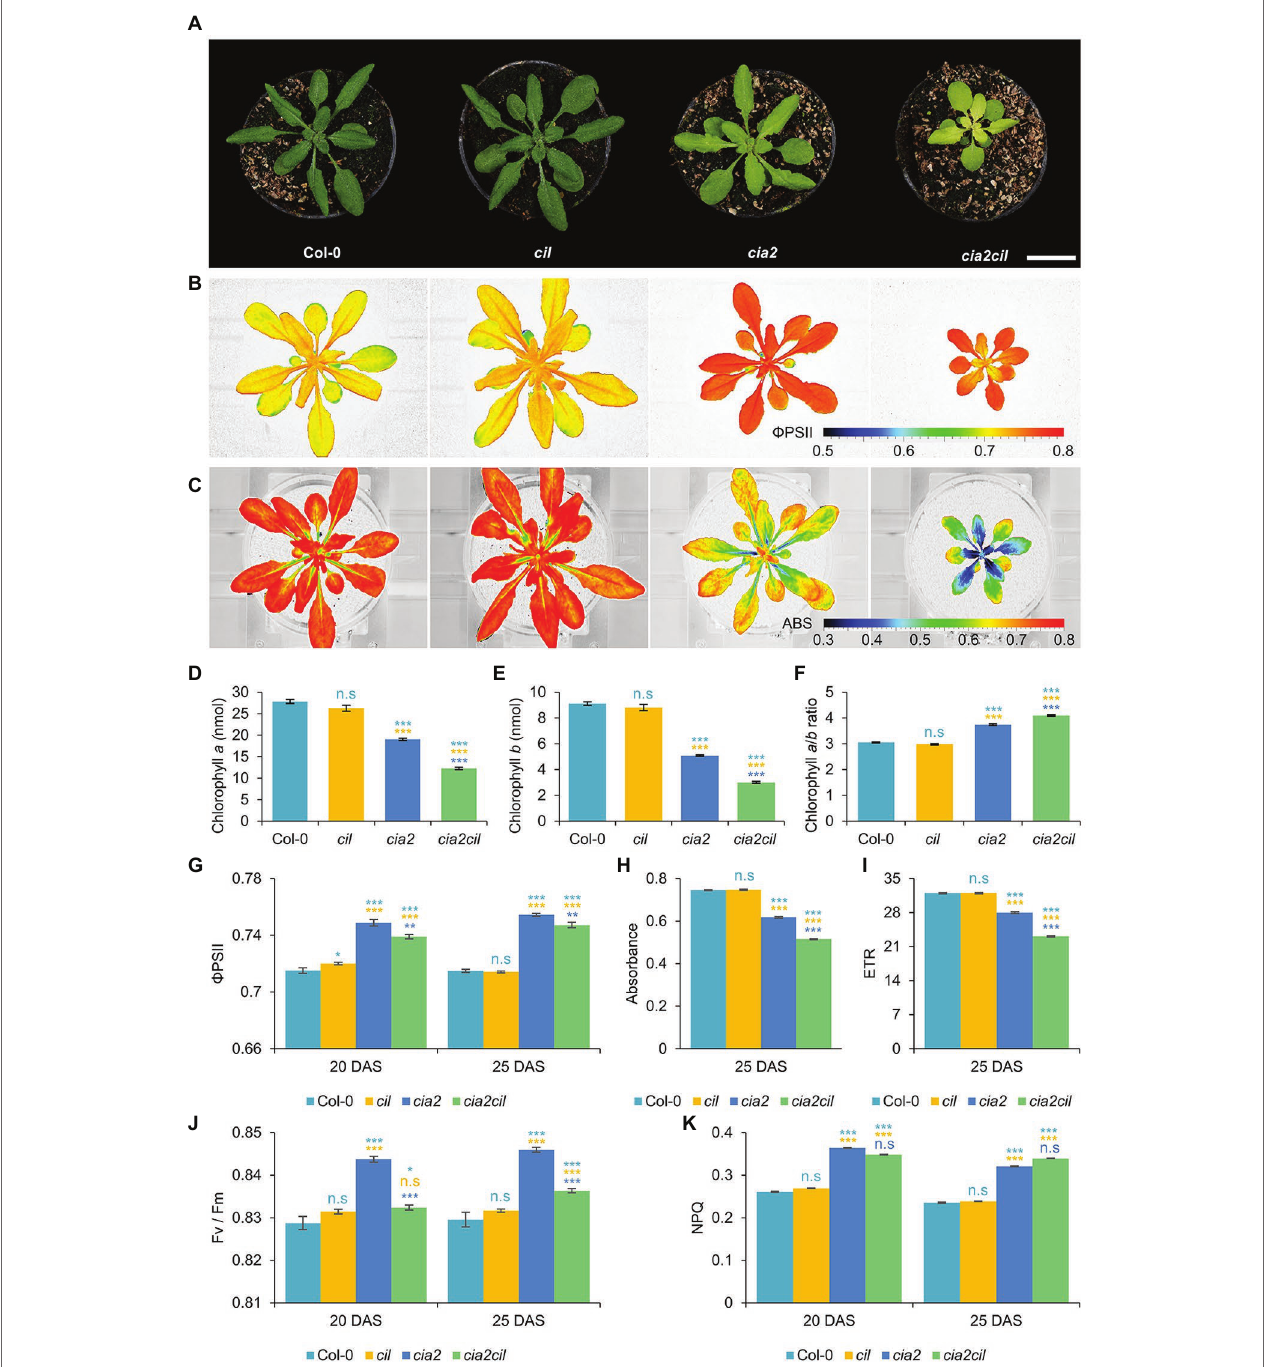
FIGURE 4 | Measurement of chlorophyll content and photosynthetic performance of wild type Col-0 and cil , cia2 , and cia2cil mutants. (A) Phenotype of Col-0, cil , cia2 , and cia2cil plants. Scale bar, 2 cm. (B) False-color images of the operating light use efficiency of PSII ( Φ PSII). (C) False-color images of normalized difference vegetation index (NDVI) imaging of actinic light absorbance. (D–F) Quantification of chlorophyll a (D) , chlorophyll b (E) , and ratios of chlorophyll a to b (F) . The chlorophyll content was measured for 50 mg leaf material. (G–K) Measurement of photosynthetic parameters. Results are presented as mean ± SEM. Number of plants used for chlorophyll content measurement N = 10; number of plants used for photosynthetic measurement N = 15. Student’s t-test (Tails = 2; Type = 2) significant levels, n.s, not significant; * p < 0.05; ** p < 0.01; *** p < 0.001. From top to bottom: statistical analysis of significance was performed as compared to Col-0, cil , and cia2 , respectively. Φ PSII, photosystem II operating efficiency; Absorbance, absorbance of actinic light; ETR, electron transport rate; F v /F m , maximum quantum yield of PSII photochemistry measured in the dark-adapted state; NPQ, non-photochemical quenching. DAS, days after sowing. Plants and images shown in panels (A–C) were at developmental stages 20 DAS. All photosynthetic measurements were performed at 120 μ E actinic